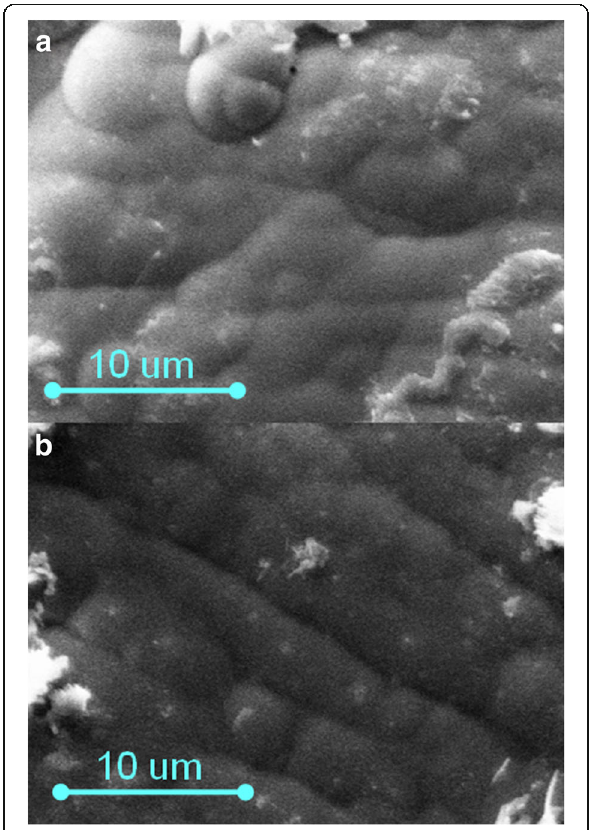
Fig. 1 SEM images of Fe-Co-W coatings of thickness 10 μ m deposited onto copper substrate. a Galvanostatic electrolysis, i =3 A dm − 2 . b Pulse mode, i =3 A dm − 2 , t on / t off =20 ms/20